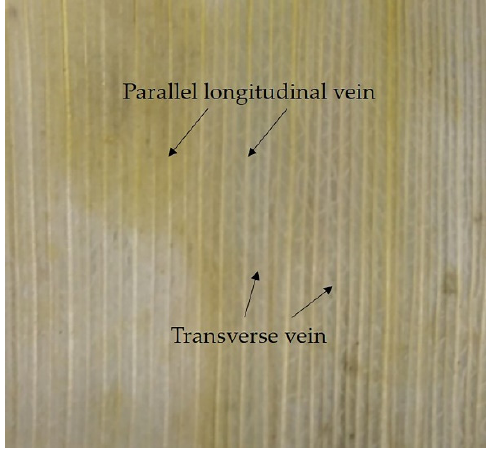
Figure 7. Vein traits of corn bract.